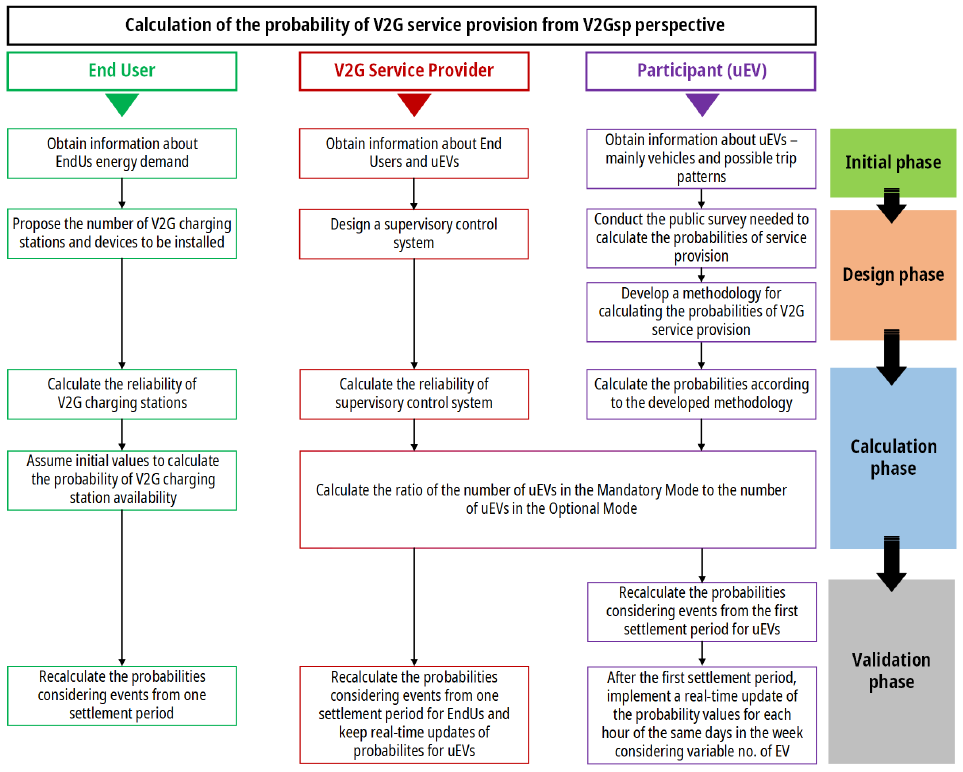
Figure 3. Methodology for calculating the probability of V2G service provision from a V2Gsp per- spective.